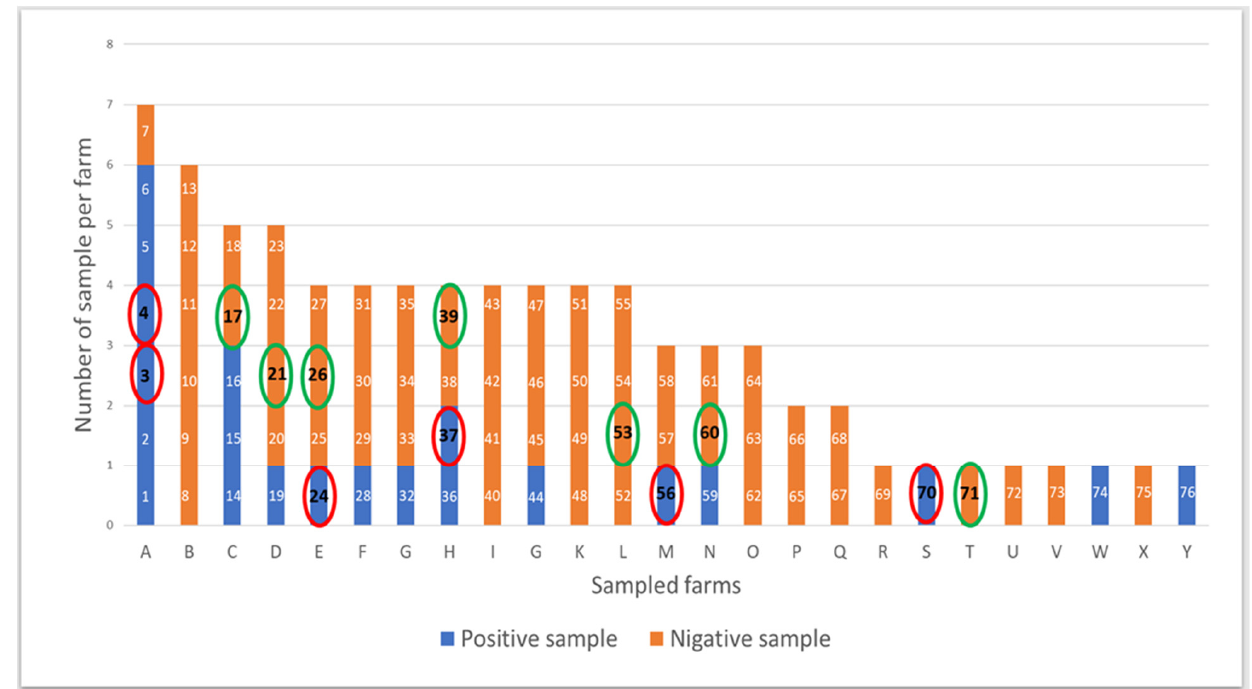
Figure 1. Samples selected randomly (13 samples: 6 among positive cultures circled in red and 7 among negative cultures circled in green) from the 76 swabs subjected to the bacteriology.